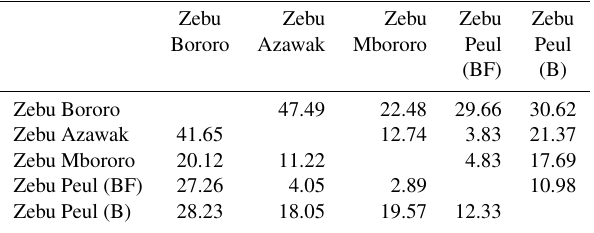
Table 3. Between-breeds Mahalanobis distance matrices computed within sex using 13 body measurements. The distance matrix com- puted on the cows’ dataset are below diagonal. The distance val- ues corresponding to the sires’ dataset are above diagonal. All dis- tance pairs are statistically significant for p < 0.0001. “(BF)” and “(B)” mean Burkina Faso and Benin,